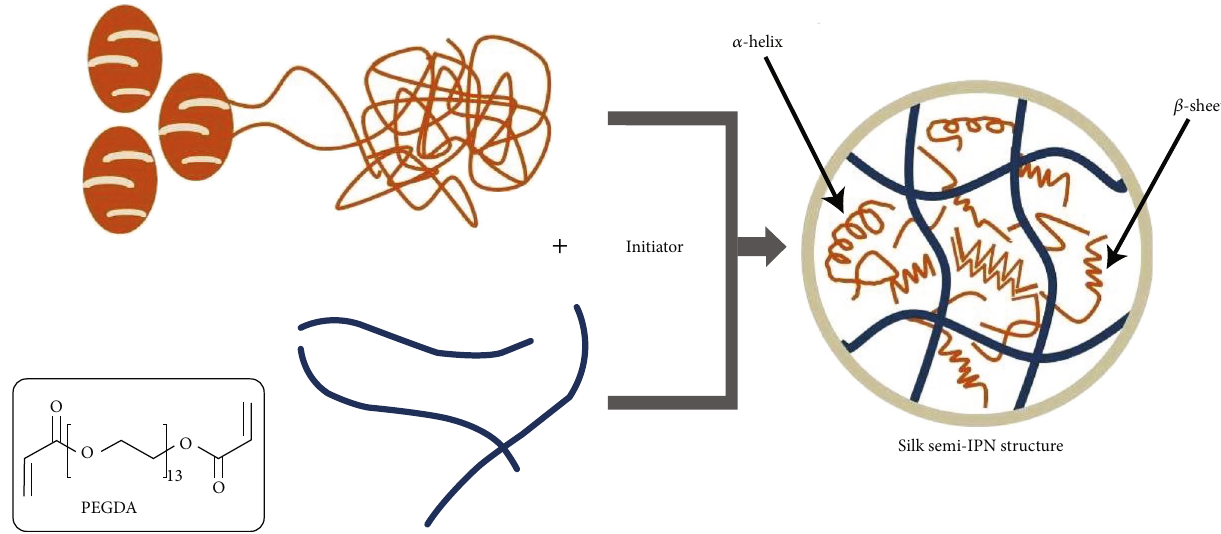
Figure 1: Schematic illustration of the formation of a SS/PEGDA semi-IPN hydrogel